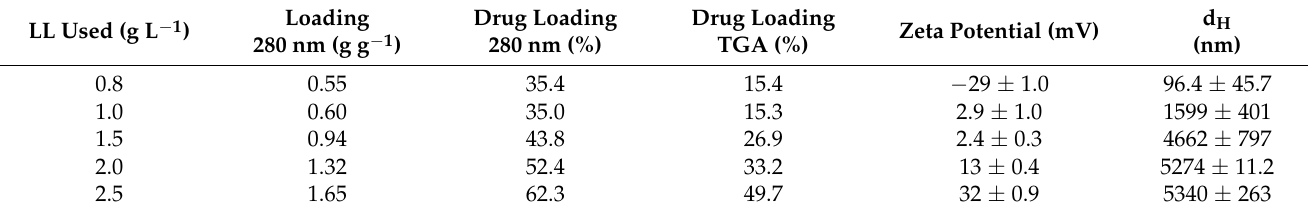
Table 2. Loadings achieved by covalently bound LL. Drug loadings were calculated from the pho- tometric and TGA data. Zeta potential sand DLS measurements were performed in Millipore ® H 2 O at a pH between 7 and 7.5.